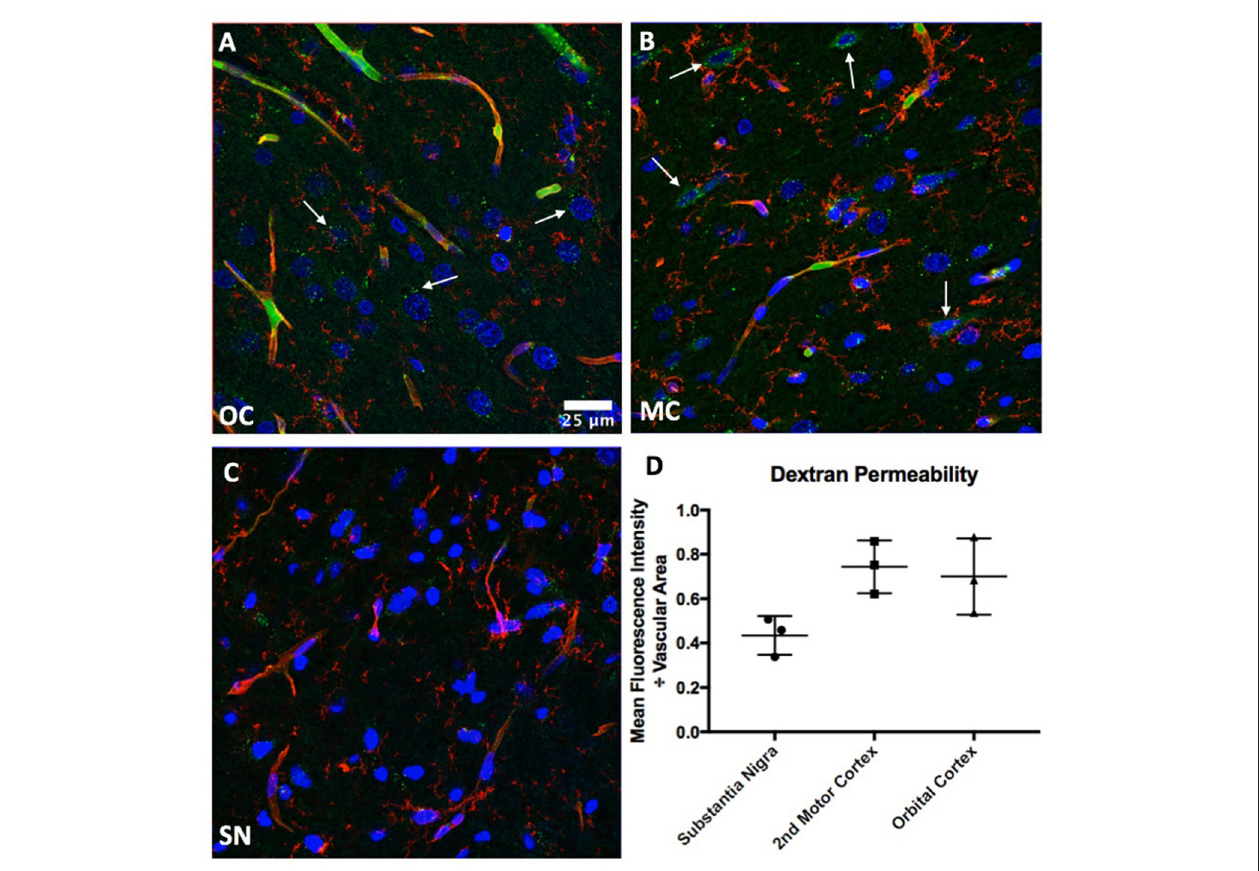
FIGURE 5 | Histological validation of BBB permeability. Fluorescent staining of the vasculature via Tomato lectin (red) demonstrates increases in FITC-dextran (green) accumulation within the parenchyma and vascular cells of the (A) orbital (OC) and (B) motor (MC) cortices, but not the (C) substantia nigra (SN). (D) Quantification of permeability. Nuclei are labeled in